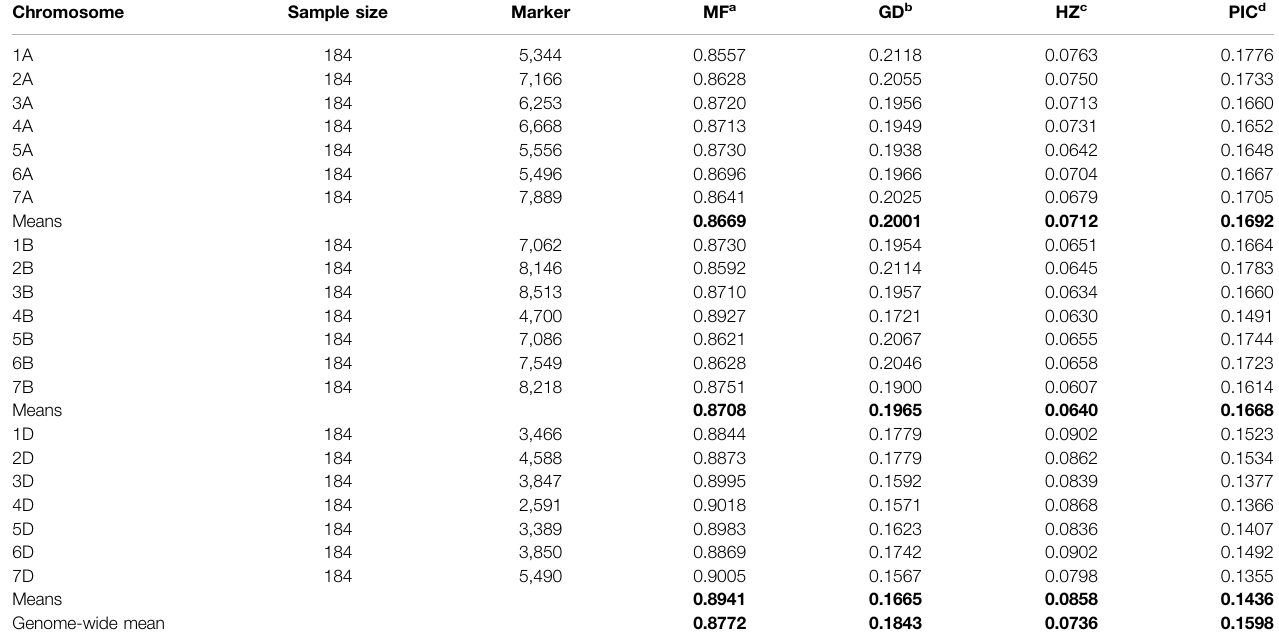
TABLE 1 | Mean major allele frequency, genetic diversity, heterozygosity, and polymorphic information content calculated using 123,596 genome-wide SNPs derived from the panel of 184 wheat genotypes. Chromosome Sample size